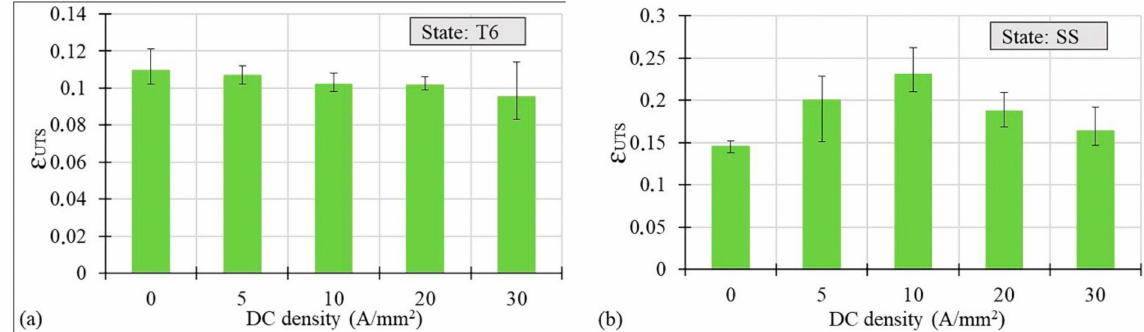
Figure 7. Uniform strain vs. DC density for the AA7075-T6 ( a ) and SS ( b )